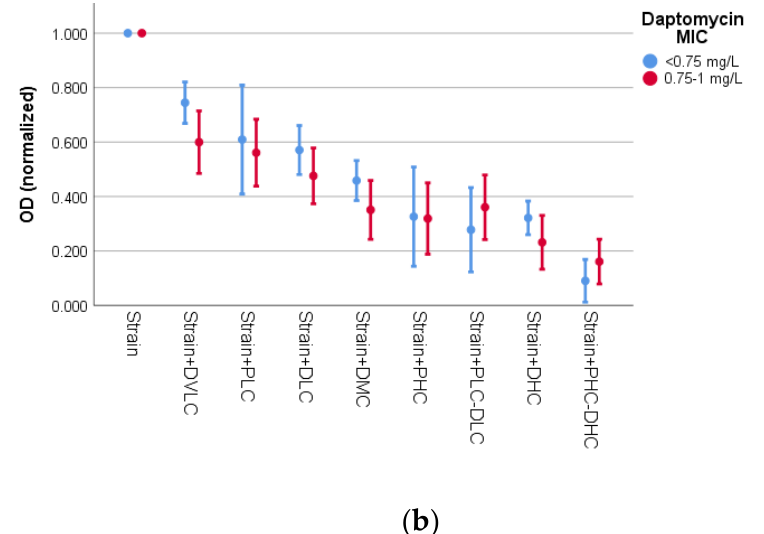
Figure 2. Effect of interventions on normalized OD of strains in relation to daptomycin MIC for ( a ) CV assay and ( b ) MTT assay. Error bars indicate mean OD ± 2 standard error. PLC: 10 4 pfu/mL (phage low concentration); PHC: 10 6 pfu/mL (phage high concentration); DVLC: 0.1 mg/L (daptomycin very low concentration); DLC: 0.5 mg/L (daptomycin low concentration); DMC: 1 mg/L (daptomycin medium concentration); DHC: 2 mg/L (daptomycin high concentration).